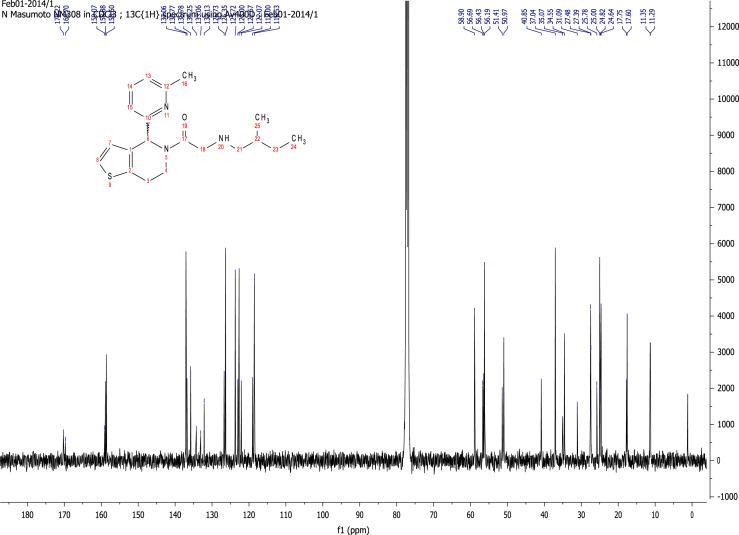
13C NMR (101 MHz, CDCl3) of RU-SKI 201
(9d).